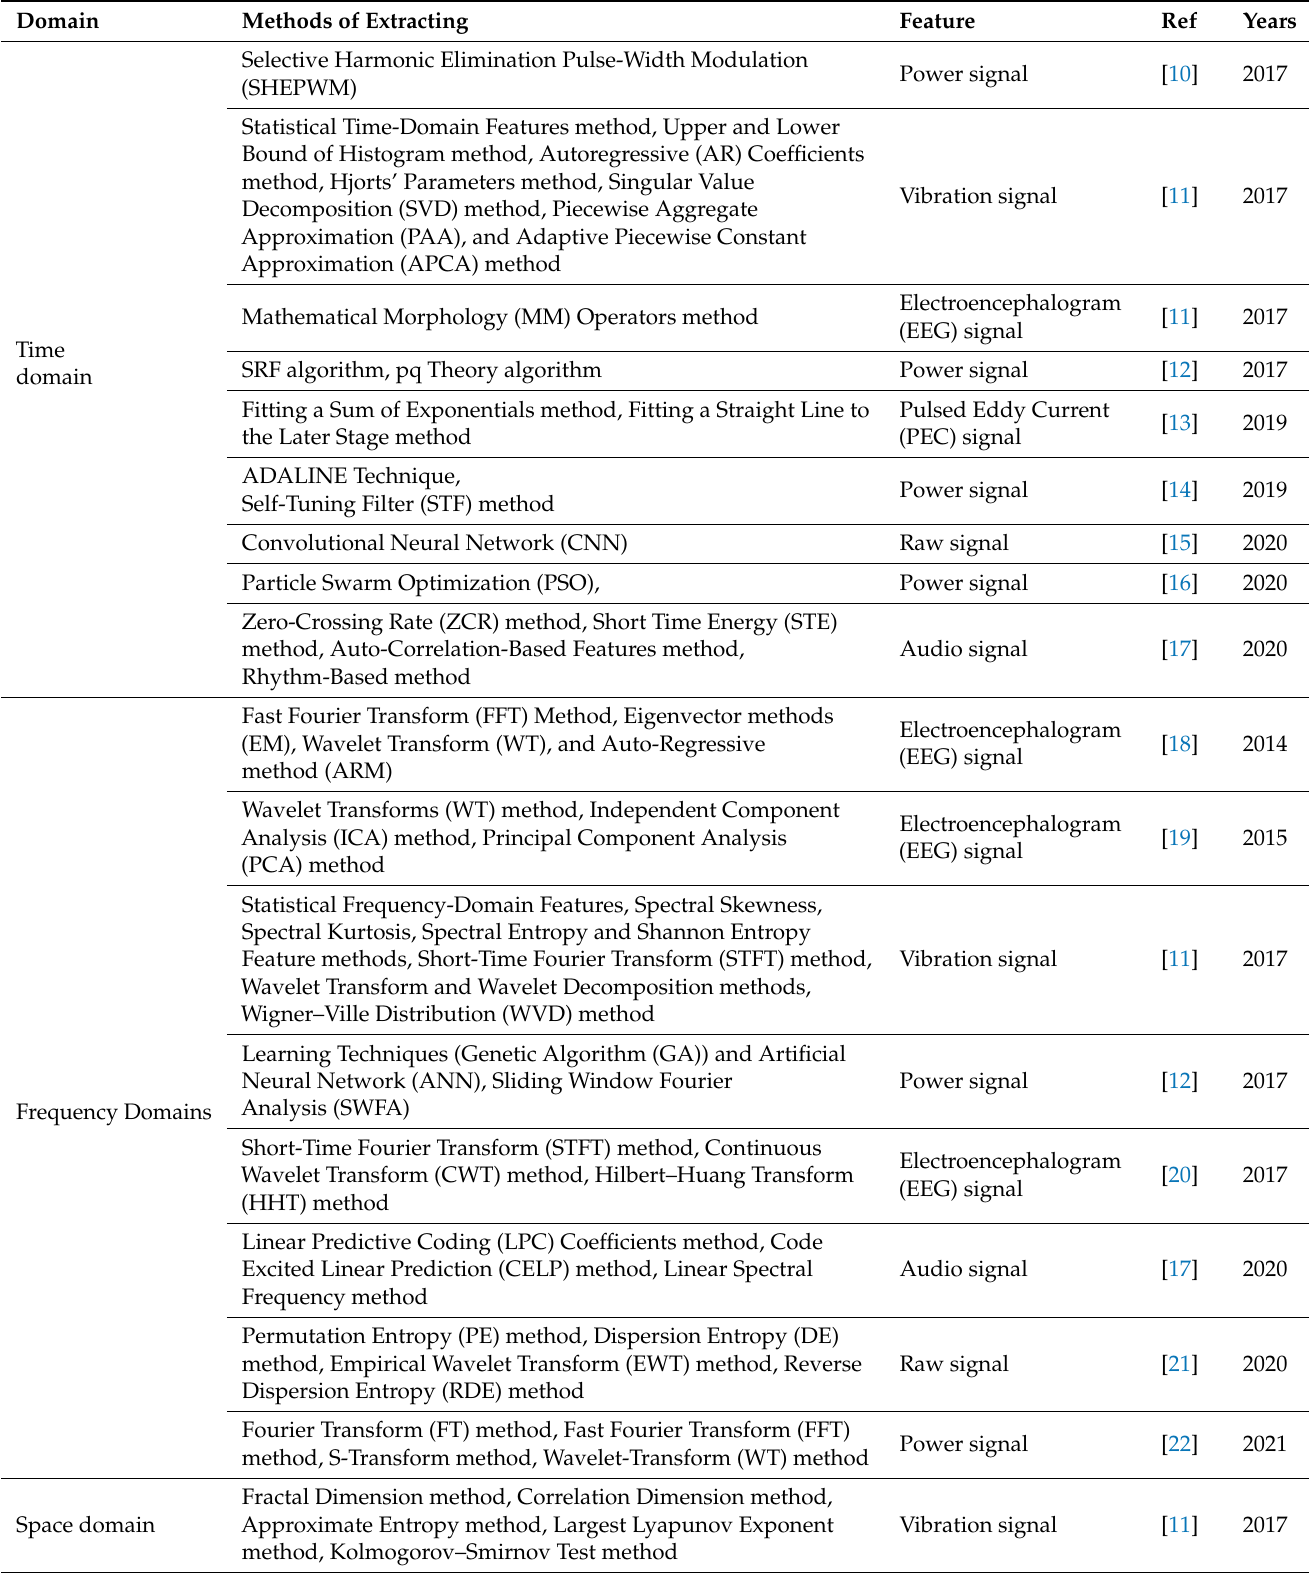
Table 1. A brief overview of previous literature review documents on methods of extracting harmon- ics in